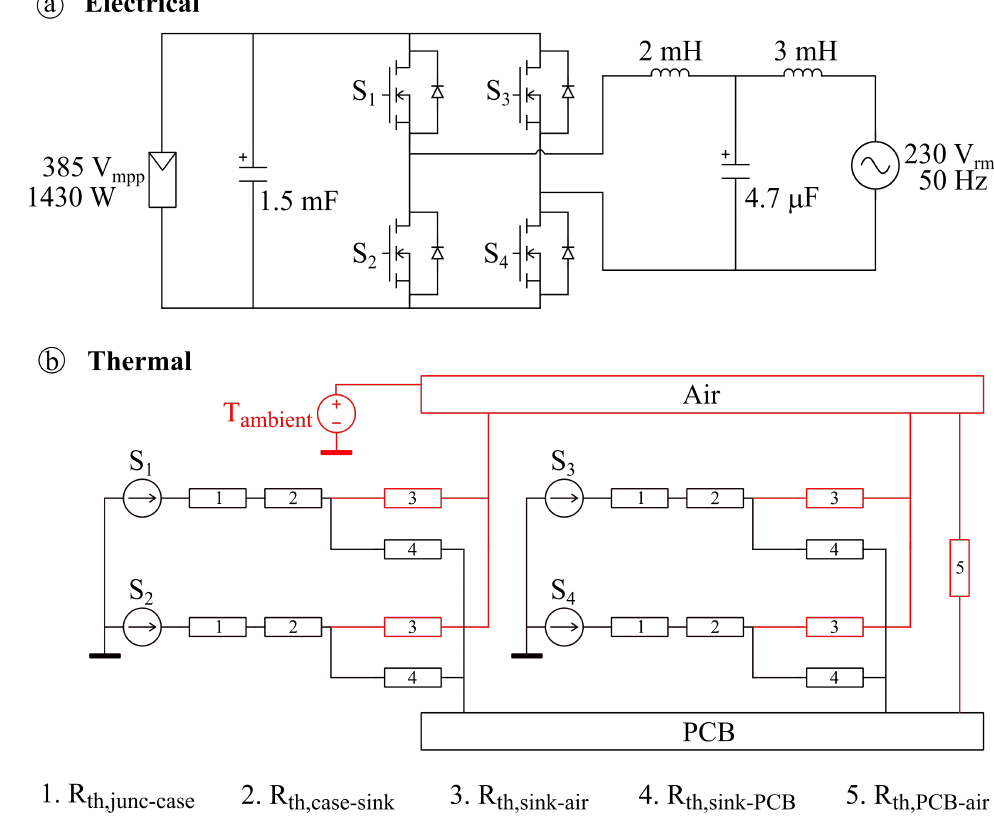
Figure 1. ( a ) The electrical circuit of a photovoltaic full-bridge inverter and ( b ) the equivalent one-dimensional (1-D) steady-state Foster thermal network for the semiconductor devices with the conductive (black) and the convective (red) heat transfer